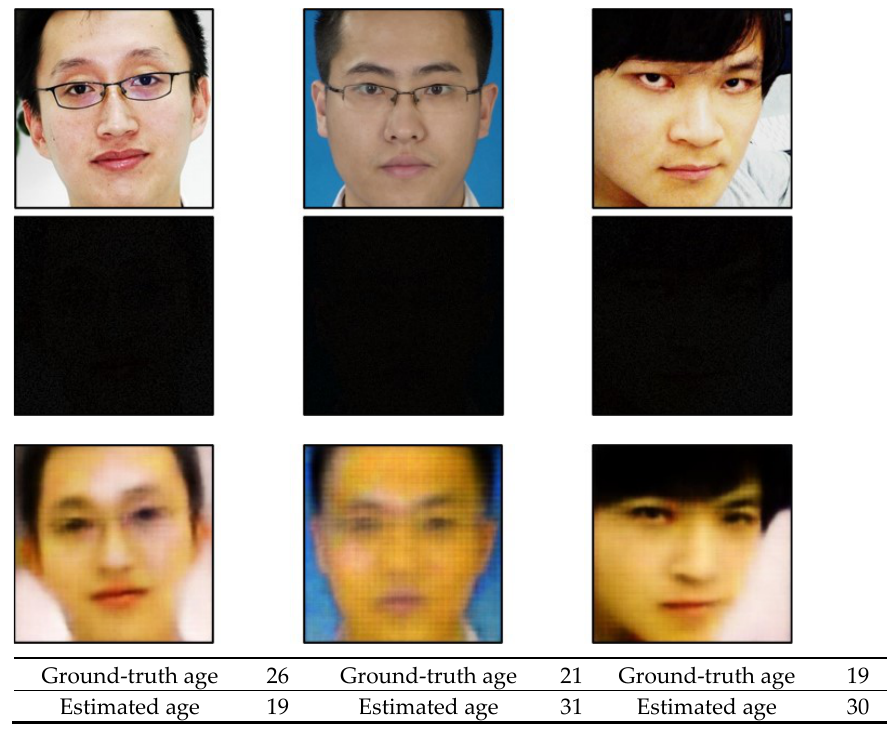
Figure 12. Bad cases of age estimation by the proposed method. The 1st, 2nd and 3rd rows show the original images, low-illuminated images, and images enhanced by LAE-GAN, respectively.